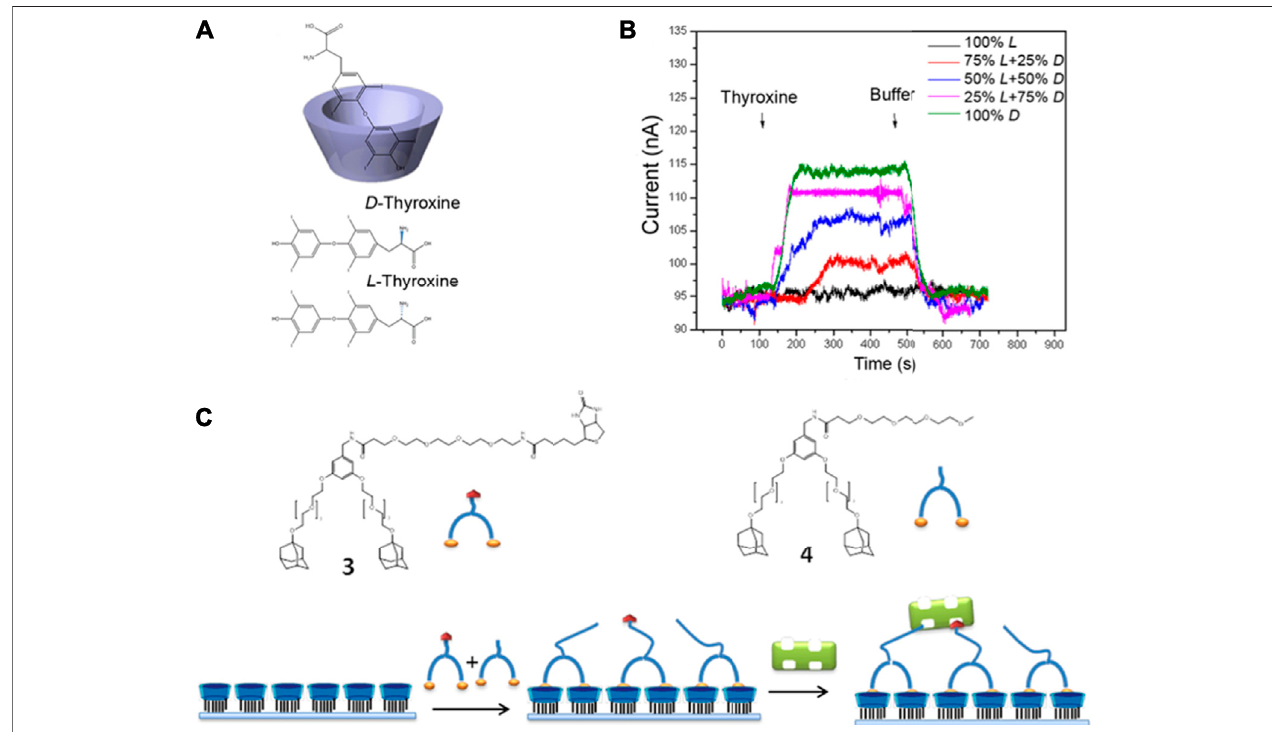
FIGURE 8 | (A, B) Detection of 1 nM L- and D -thyroxine enantiomers using Si NWFETs functionalized with β -CD. (C) Adsorption scheme for the sensing of streptavidin through a mixture of adamantyl – biotin 3) and adamantyl – oligo(ethylene glycol) 4) at the surface. Modi fi ed from (Duan et al., 2013. Copyright 2013 American Chemical